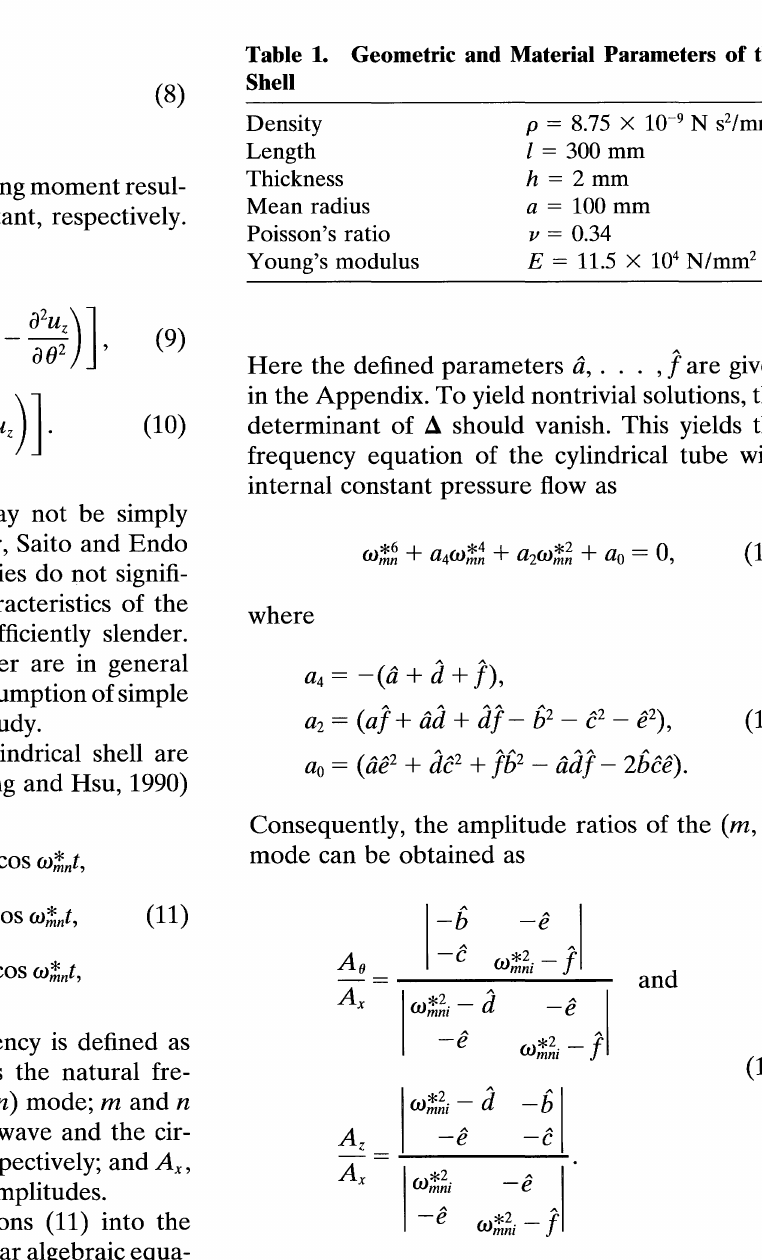
Geometric and Material Parameters of Shell